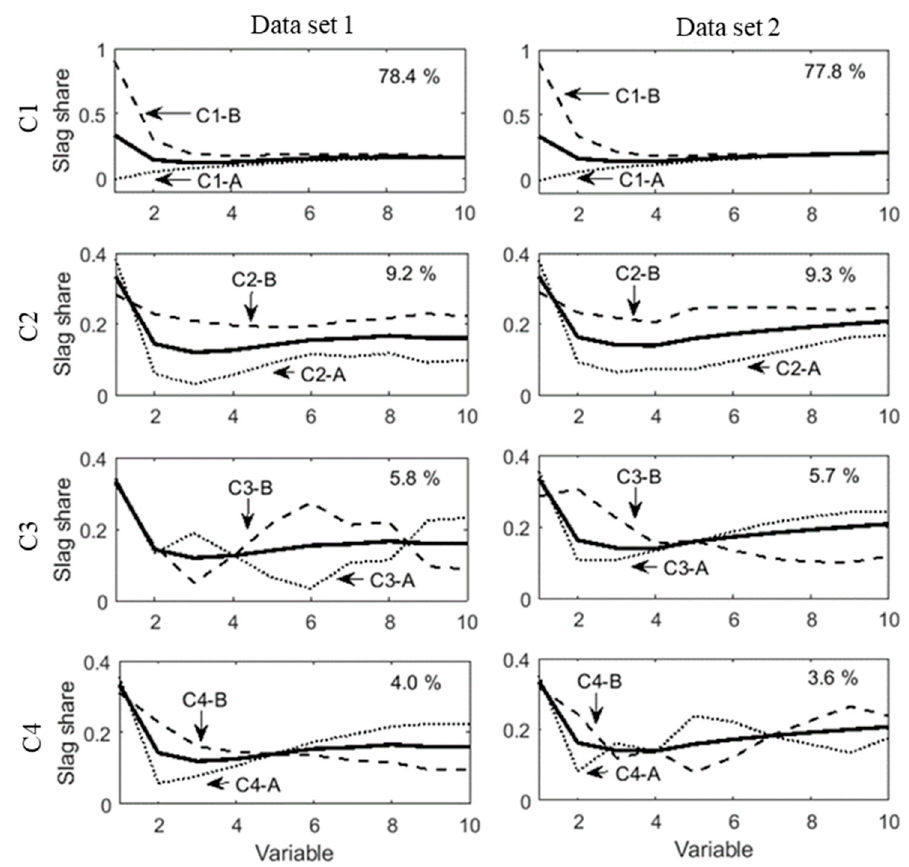
Figure 5. Slag share ranges represented by the principal component (C1 ... C4) for Data set 1 (left panels) and Data set 2 (right panels). Solid lines represent the mean pattern , dotted lines the lowest values (labelled A), and dashed lines the highest (labelled B). The percentage of variance explained by each component is reported in the right top part of each subpanel.